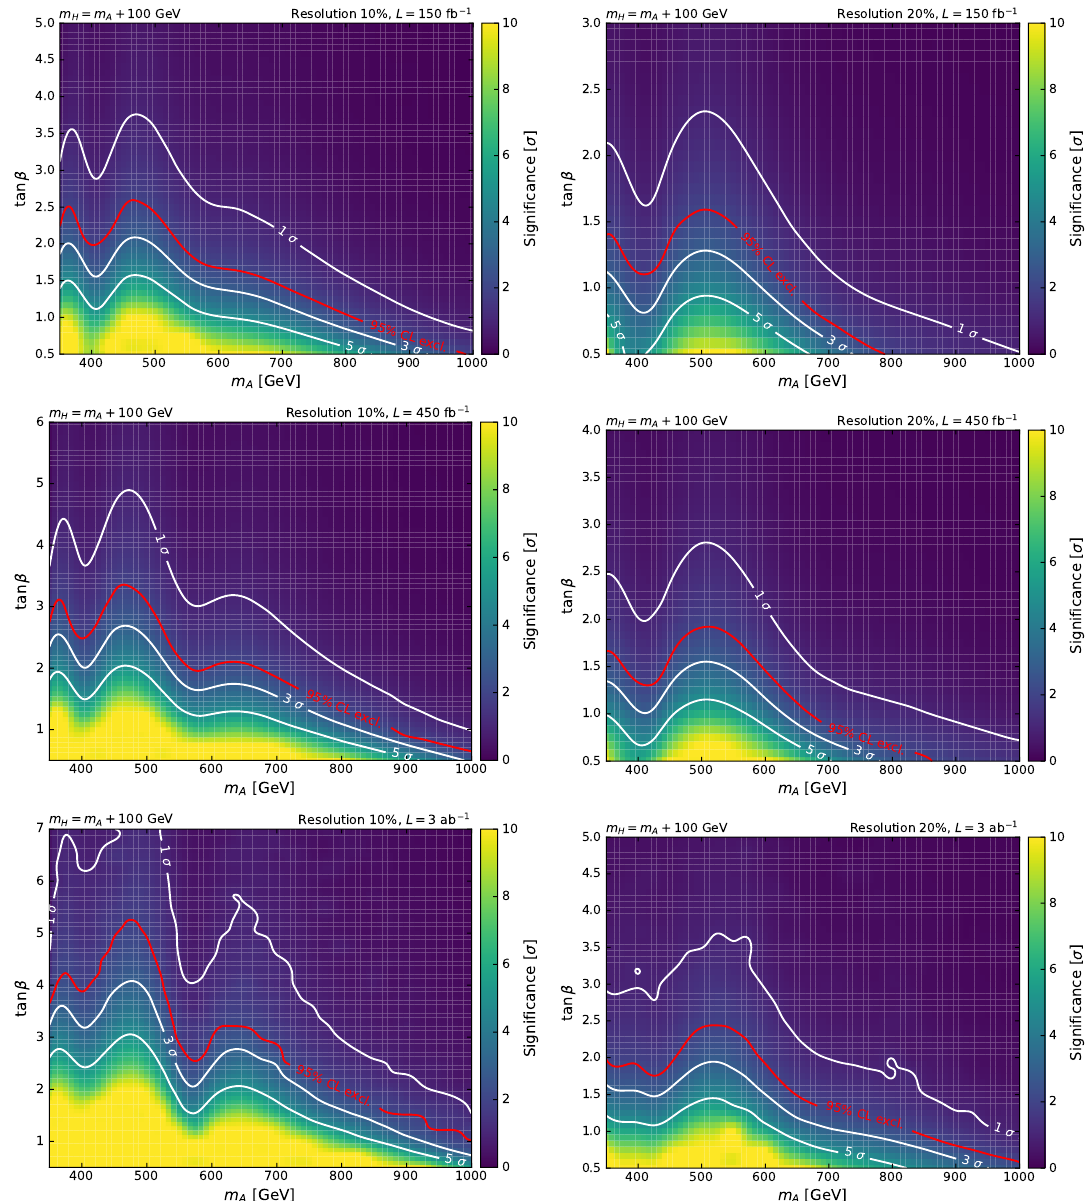
Figure 14 . Expected signi(cid:12)cance and exclusion potential for a Type II 2HDM with a mass splitting M H (cid:0) M A = 100 GeV in the same six experimental scenarios as considered in (cid:12)gure 10. Values of signi(cid:12)cance in excess of 10 (cid:27) are clipped. A resolution of 10% and 20% is assumed for the left- and the right-hand side plots,